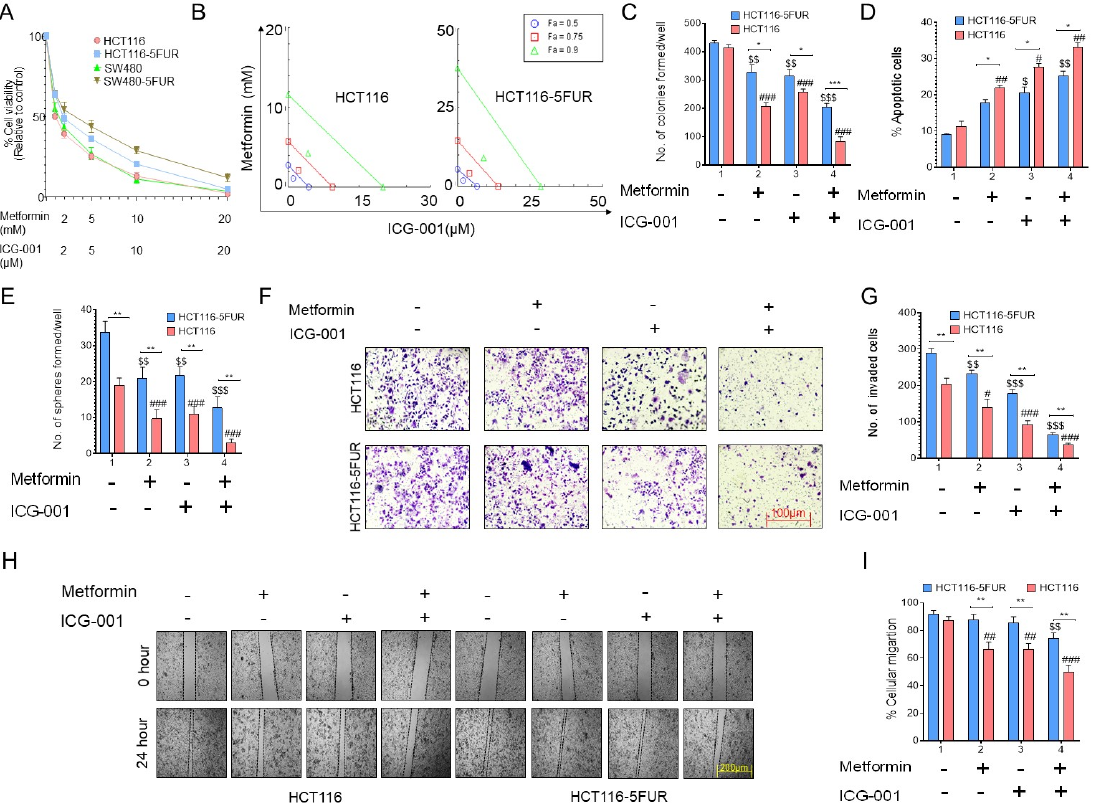
Figure 4. Combined effect of metformin and ICG-001 in parental and 5FUR CRC cells. ( A ) Measure- ment of percentage cell viability using a CCK-8 assay after treatment with metformin (1–20 mM) and ICG-001 in parental and HCT116-5FUR cells for 48 h. ( B ) Isobologram analysis to determine the mechanism of action of metformin and ICG-01 in parental and HCT116-5FUR cells. ( C ) Colony- forming ability and ( D ) measurement of the percentage of apoptotic cells. ( E ) Sphere-forming ability after treatment with metformin and ICG-001 for 48 h, either alone or in combination, in parental and 5FUR CRC cells. ( F ) Representative images and ( G ) a graphical representation of the number of invaded cells after treatment with metformin and ICG-001 for 48 h, either alone or in combi- nation. ( H ) Representative images of wound and ( I ) a graphical representation of percentage of wound closure after 24 h of treatment with metformin and ICG-001, either alone or in combination. Statistical significance was determined by a Student’s t -test. (Comparison between Parental